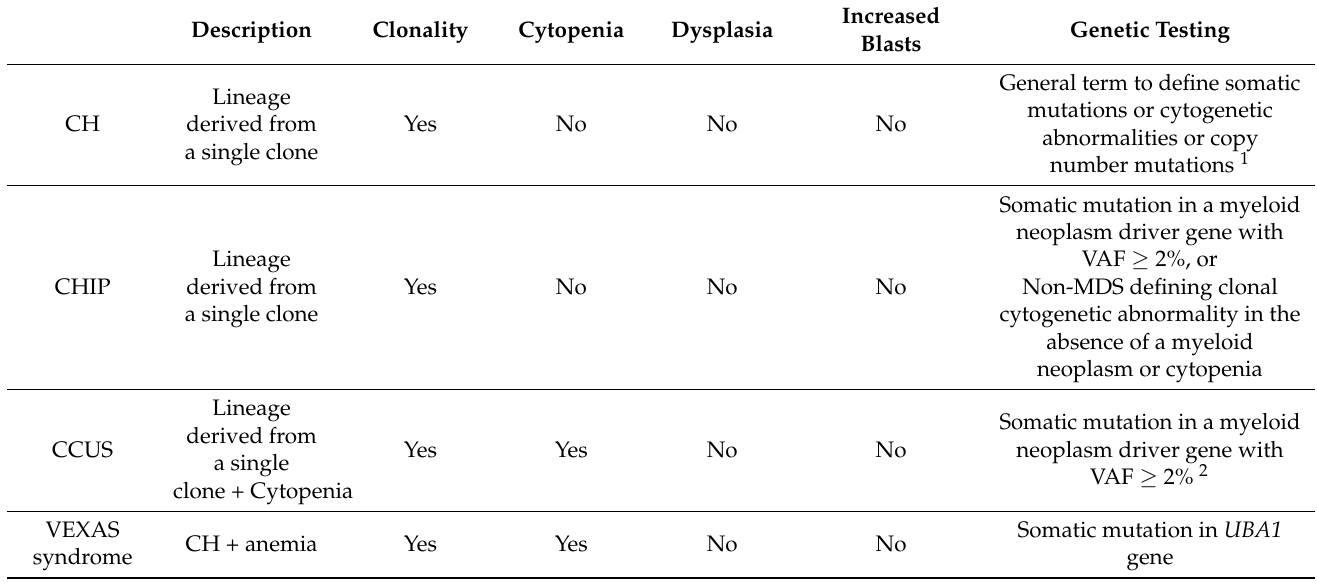
Table 2. Pre-malignant myeloid clonal